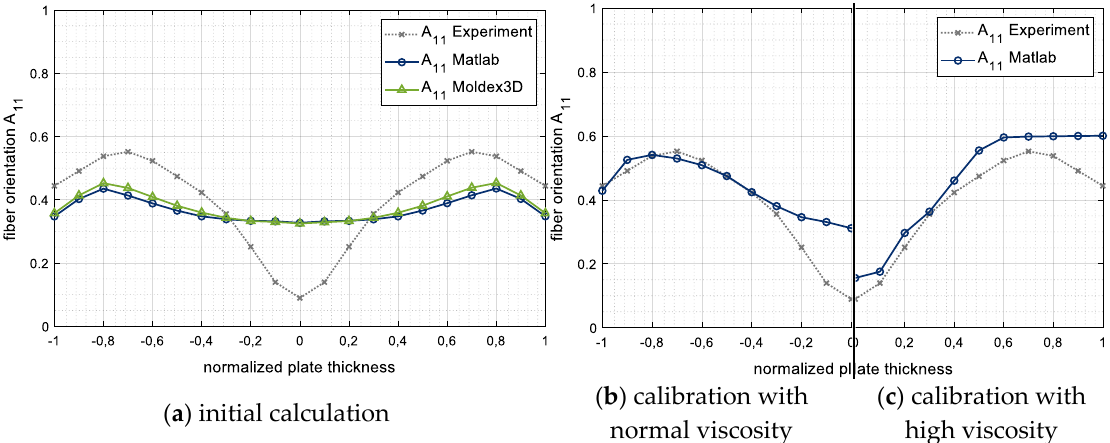
Figure 24. Calculation and calibration results of the fiber orientation calibration tool.